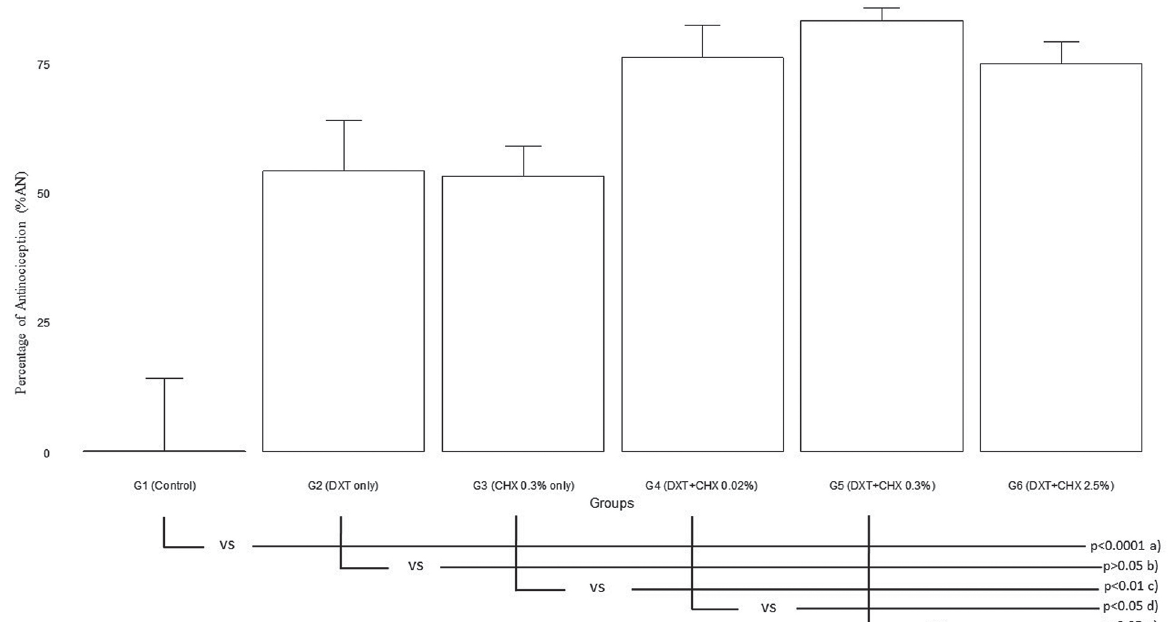
FIGURE 3 - Antinociceptive effects (%AN) of control and experimental groups in the second phase of formalin test. Data are present in Mean±S.E.M. of n=6 rats for each group. The letters represent the planned contrast ANOVA: a) G1 vs G2, G3, G4, G5, G6; b) G2 vs G3, G4, G5, G6; c) G3 vs G4, G5, G6; d) G4 vs G5, G6 and e) G5 vs G6.